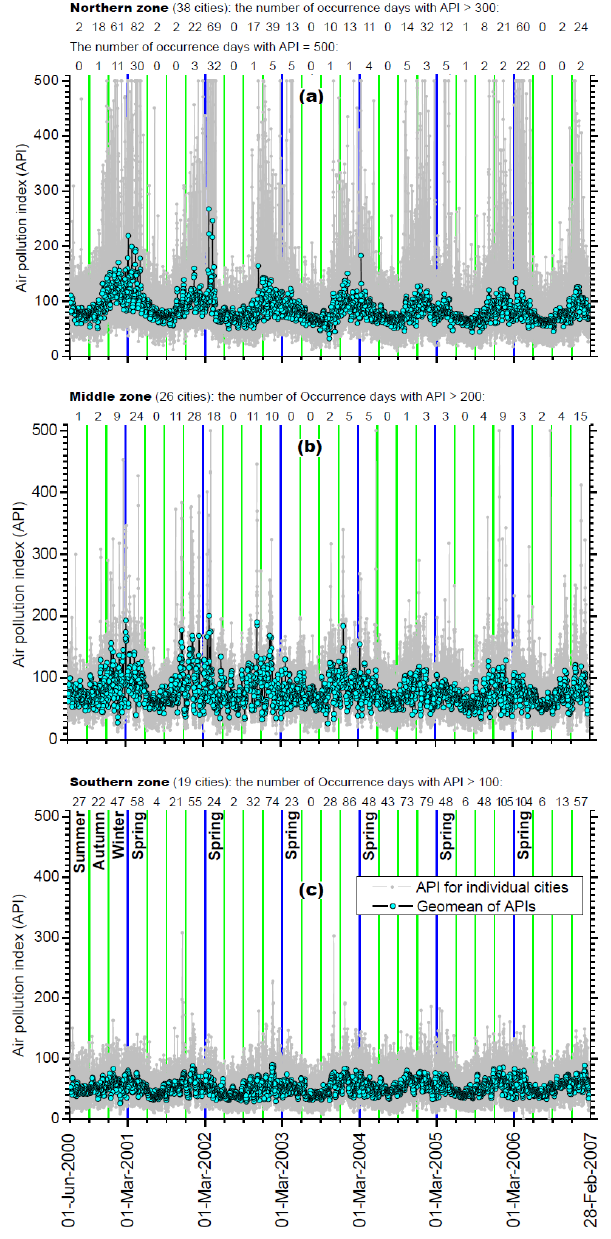
Fig. 4. Variations of the daily air pollution indexes (APIs) for the (a) northern, (b) middle, and (c) southern latitudinal zones. Light gray dots linked with light gray straight solid lines denote the daily APIs for the individual cities, while cyan dots linked with black straight solid lines donate the daily geometric mean APIs for the three latitudinal zones. The numbers of occurrence days with high APIs for the cities in the three latitudinal zones are also presented at the top of (a), (b) and (c).